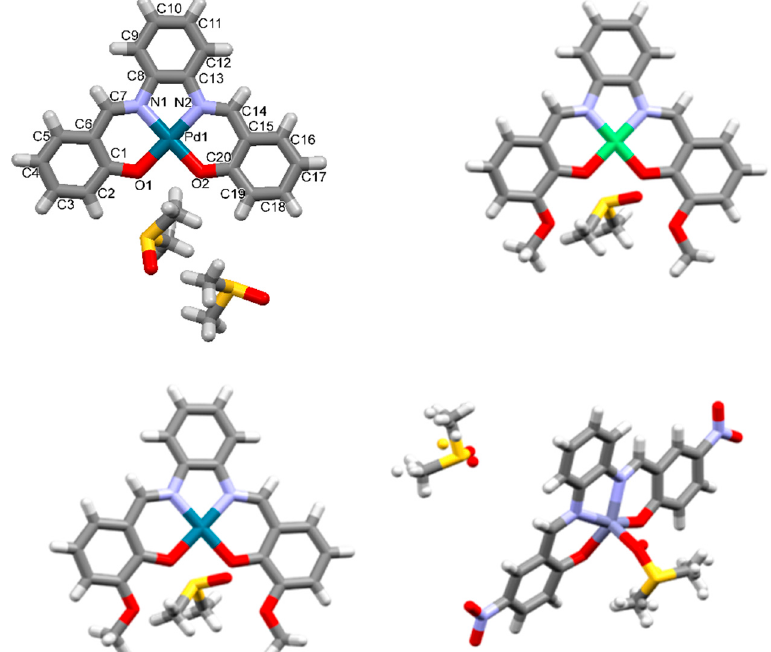
Figure 5. Asymmetric unit of 1Pd , top left, 2Ni , top right, 2Pd bottom left, and 3Zn , bottom right, obtained as DMSO solvates and adducts (shown in capped stick representation). Crystallographic labelling scheme is provided for 1Pd.